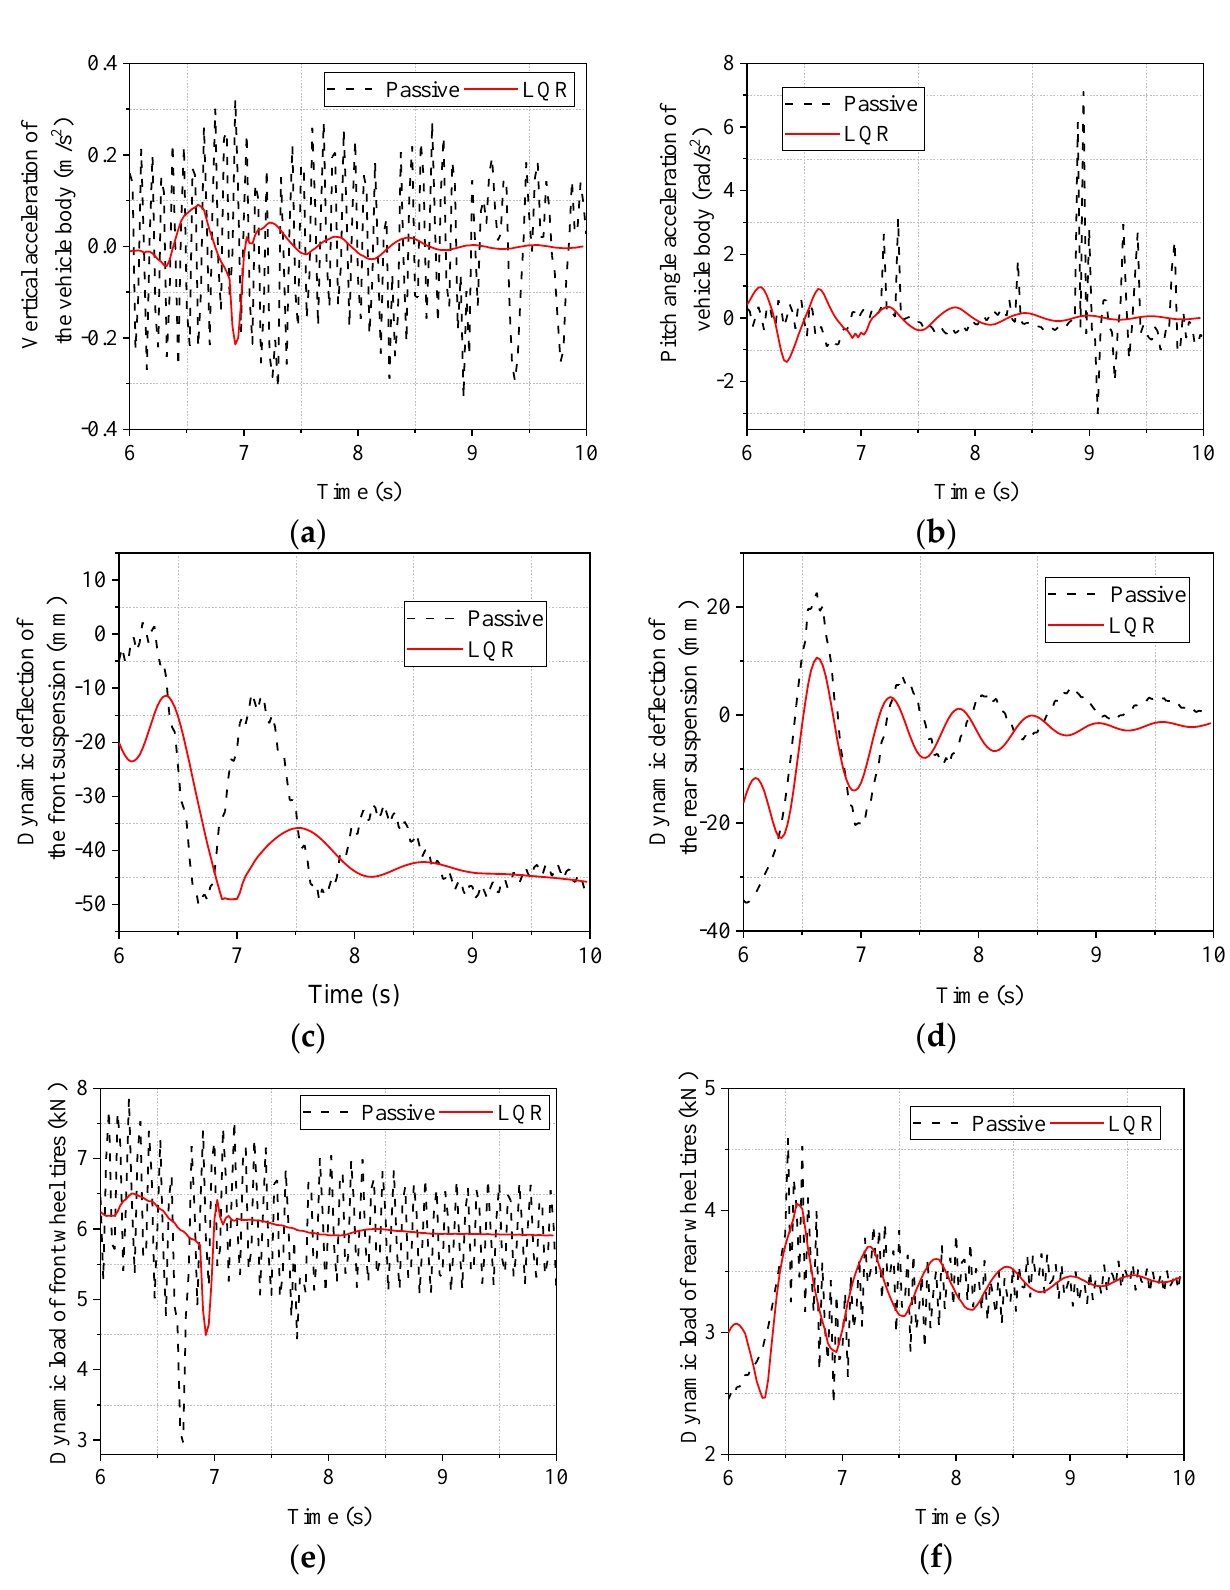
Figure 13. Simulated time domain response of emergency braking condition. ( a ) body vertical acceleration; ( b ) body pitch angle acceleration; ( c ) front suspension dynamic deflection; ( d ) rear suspension dynamic deflection; ( e ) front wheel tire dynamic load; ( f ) rear wheel tire dynamic load.